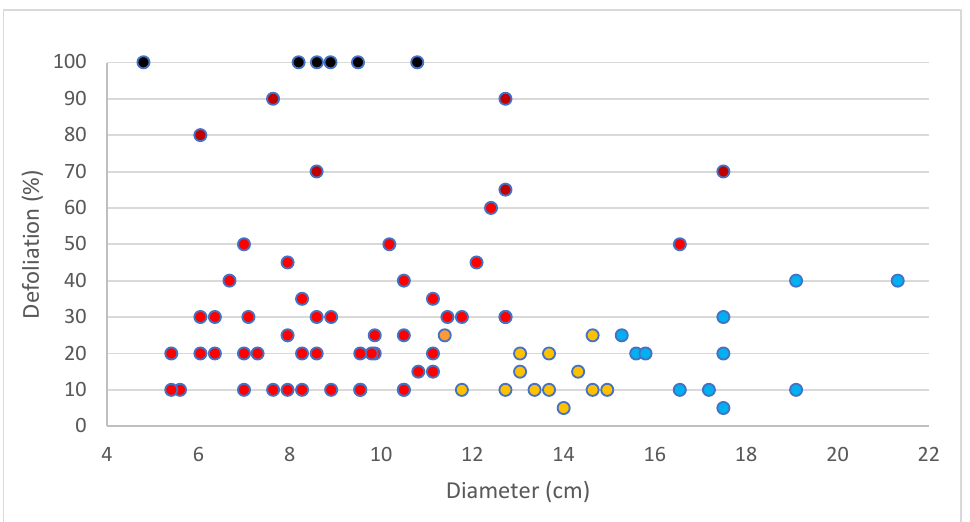
Figure 10. Selection of the trees of U. laevis trees that are tolerant to O . novo-ulmi and the local environmental conditions (forest field) {II-blue: D > Dm + s, III-orange: D > Dm, black dots: dead, brown dots: dying individuals, and red dots: not selected trees}.